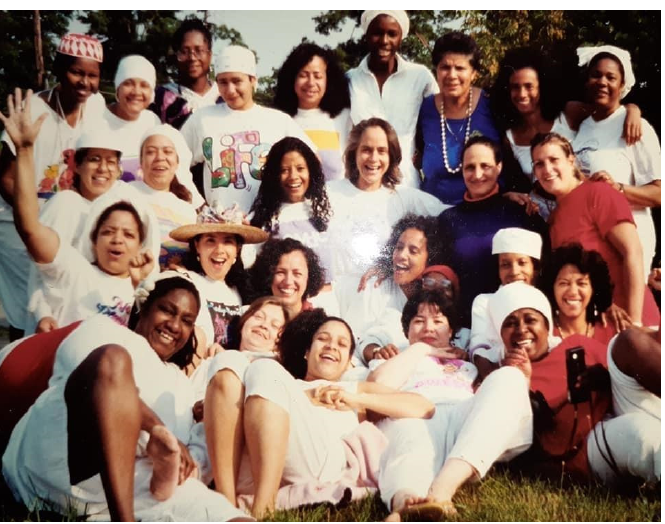
Figure 1. First World Women of Color Self-Healing Circle Retreat. 1992. Picture by Esperanza Martell Martell Archives.